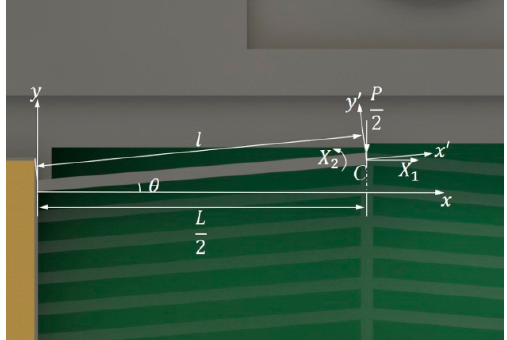
Figure 10. The V-shape beam in the chevron actuator.